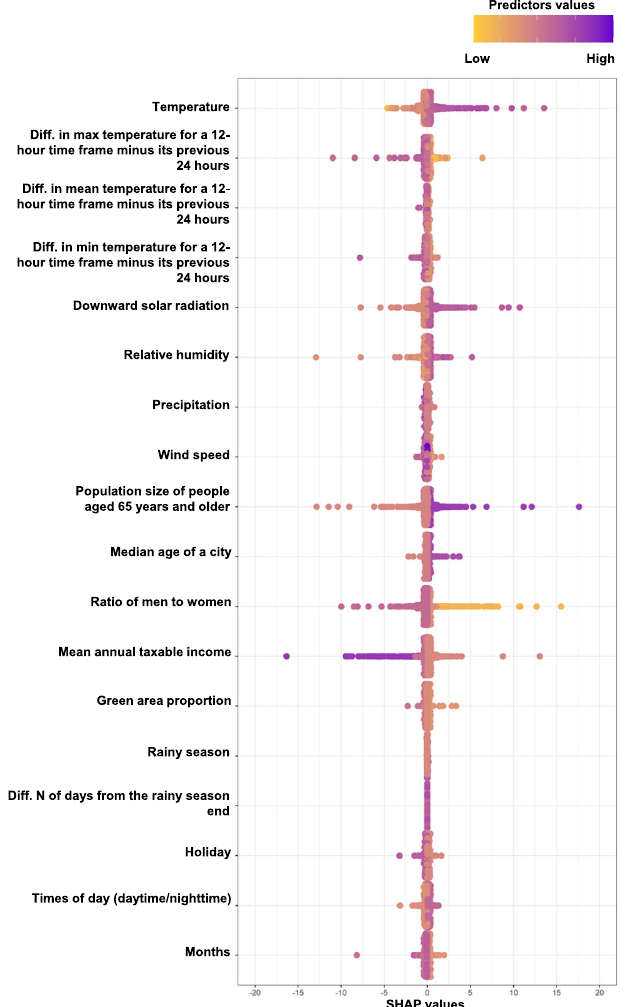
Fig. 5 Importance of predictors for the number of heatstrokes of hospital admission and death cases based on SHAP values in the best GAM. Plots show importance of the predictors in the best prediction models (i.e., the GAM using multivariable predictors) by SHAP values. The yellow to purple dots represent low to high values of each predictor. The x-axis shows the SHAP value, the contribution of each predictor to the predicted number of heatstrokes of which positive values tend to predict a higher number of heatstroke cases and negative values tend to predict a lower number of heatstroke cases. When standardized values of wind speed and precipitation were over 5, the values were treated as 5. SHAP values over 20 or under − 20 were eliminated, but there were few such values (only 1 case). SHAP SHapley Additive exPlanations, Diff. N difference number, GAM generalized additive